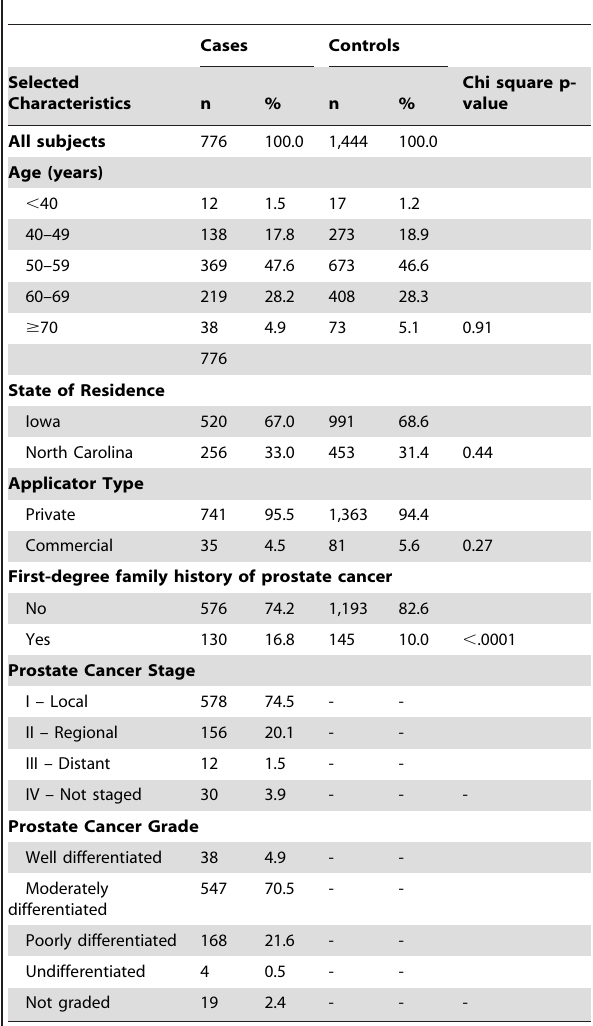
Table 1. Selected characteristics of prostate nested case- control